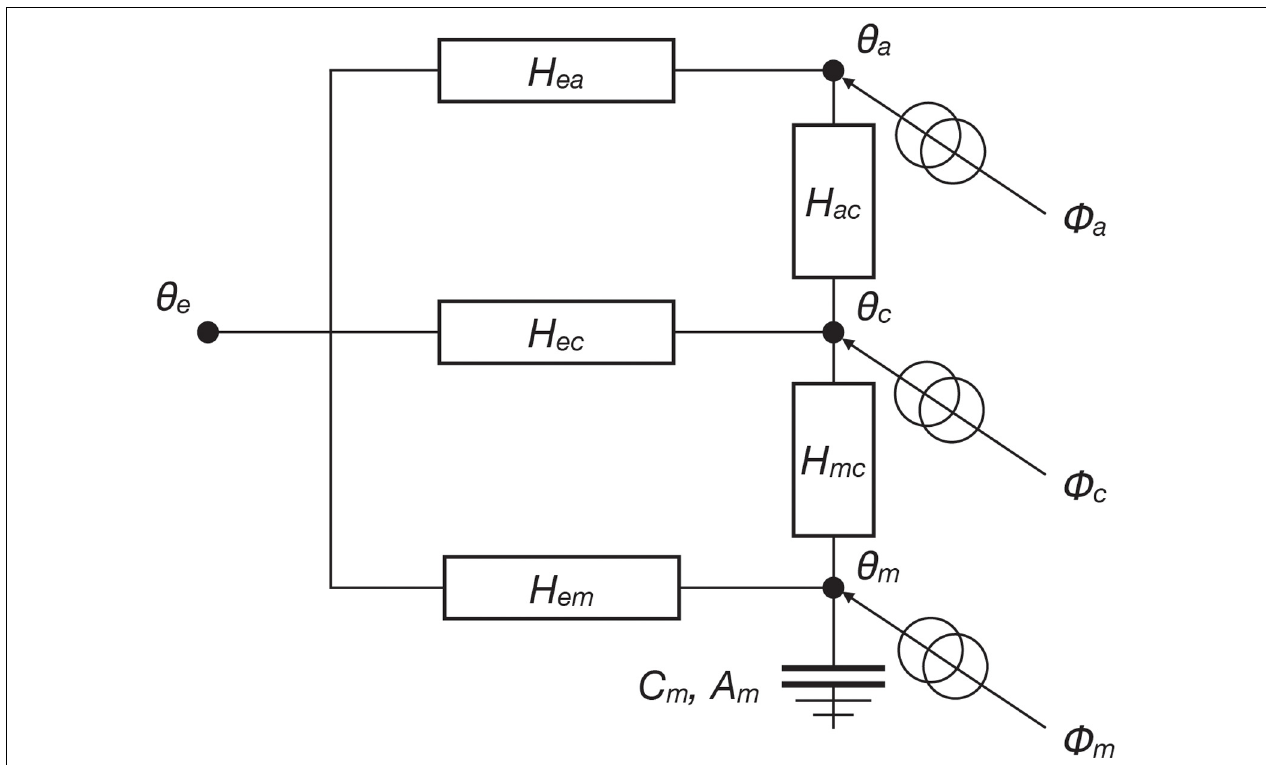
FIGURE 2 | Resistance-capacitance (RC) model used in CEA (adapted from SIA Merkblatt 2044). θ e , θ a , θ c , and θ m are the temperatures of the exterior air, indoor air, surface node, and building thermal mass, respectively. H ea is the air heat flow coefficient of the ventilation systems, whereas H ec and H em are the transmission heat coefficients lightweight and heavyweight building materials, respectively, and the heat transfer coefficients between the air and surface node, and between the surface node and the thermal mass are H ac and H mc , respectively. The internal and solar gains in the air, surface and thermal mass nodes are (cid:56) a , (cid:56) c and (cid:56) m , respectively. Finally, C m and A m are the internal heat capacity and effective mass area of the